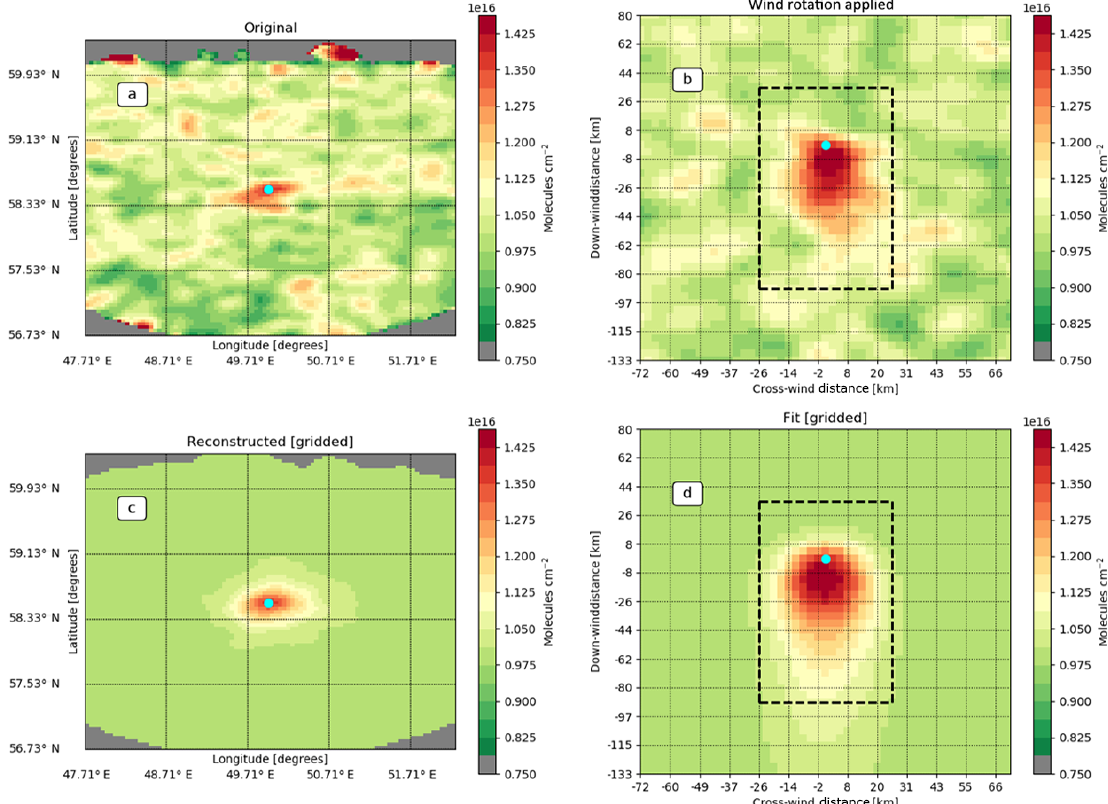
Figure 3. Fit example for the fertilizer plants in the ZMU fertilizer plant in Kirovo-Chepetsk, Russia. Panel (a) shows the original CrIS NH 3 total columns (2013–2017) gridded at a 0.05 ◦ × 0.04 ◦ (long, lat) resolution and smoothed using the pixel-averaging technique with a 15km radius to represent the footprint. Panel (b) shows the same observations after applying the wind rotation algorithm and gridding the observations to a 3km × 4.5km grid. Panel (d) shows the fit to the observations and (c) the reconstruction of the initial plot using the parameters found in the fit. The cyan dot indicates the source